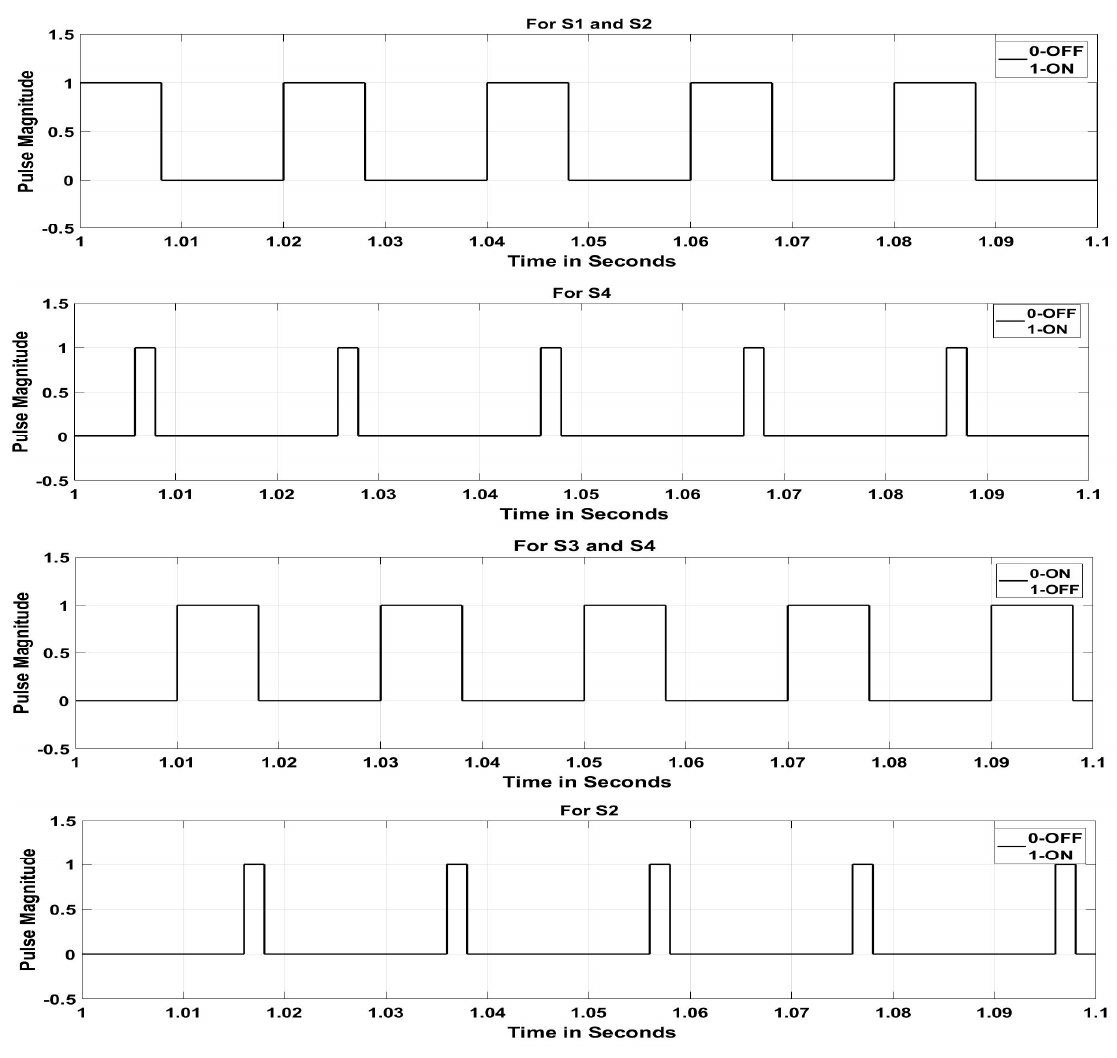
Figure 18. Simulink simulation of control pulse for inverter boost mode.